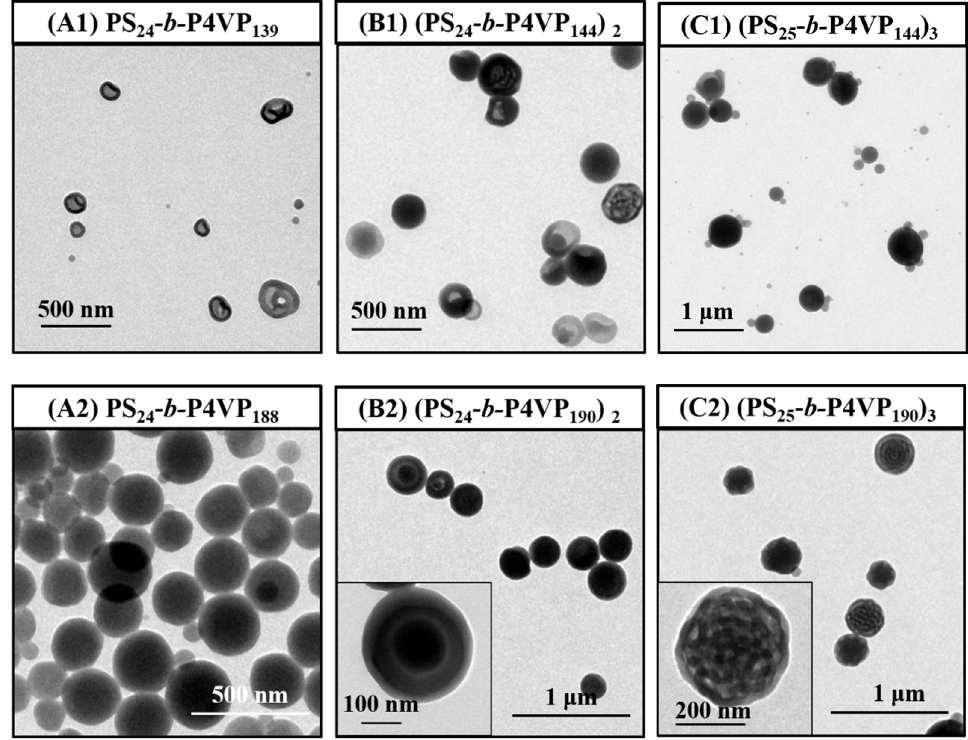
Figure 7. The TEM images of the linear or star block copolymer nanoassemblies of PS 24 - b -P4VP